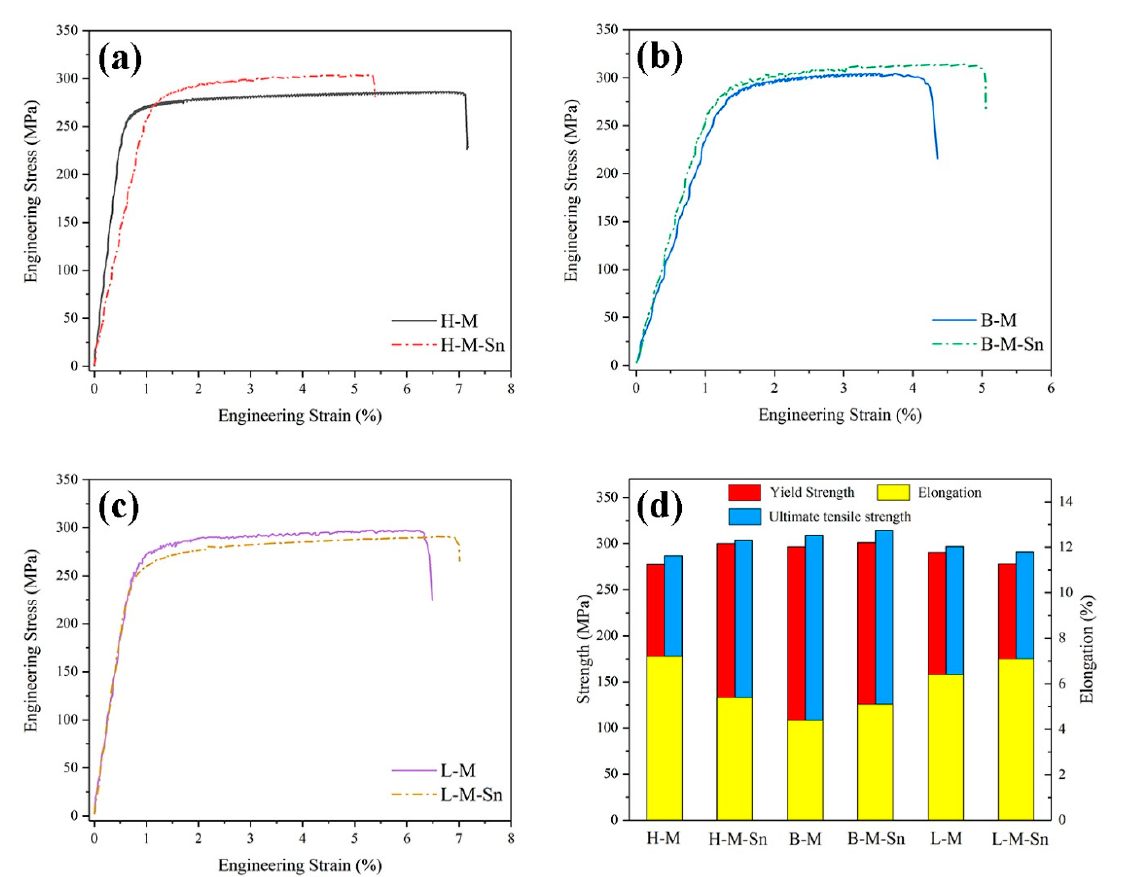
Figure 2. Room temperature tensile curves and mechanical properties of the peak aged: ( a ) H–M and